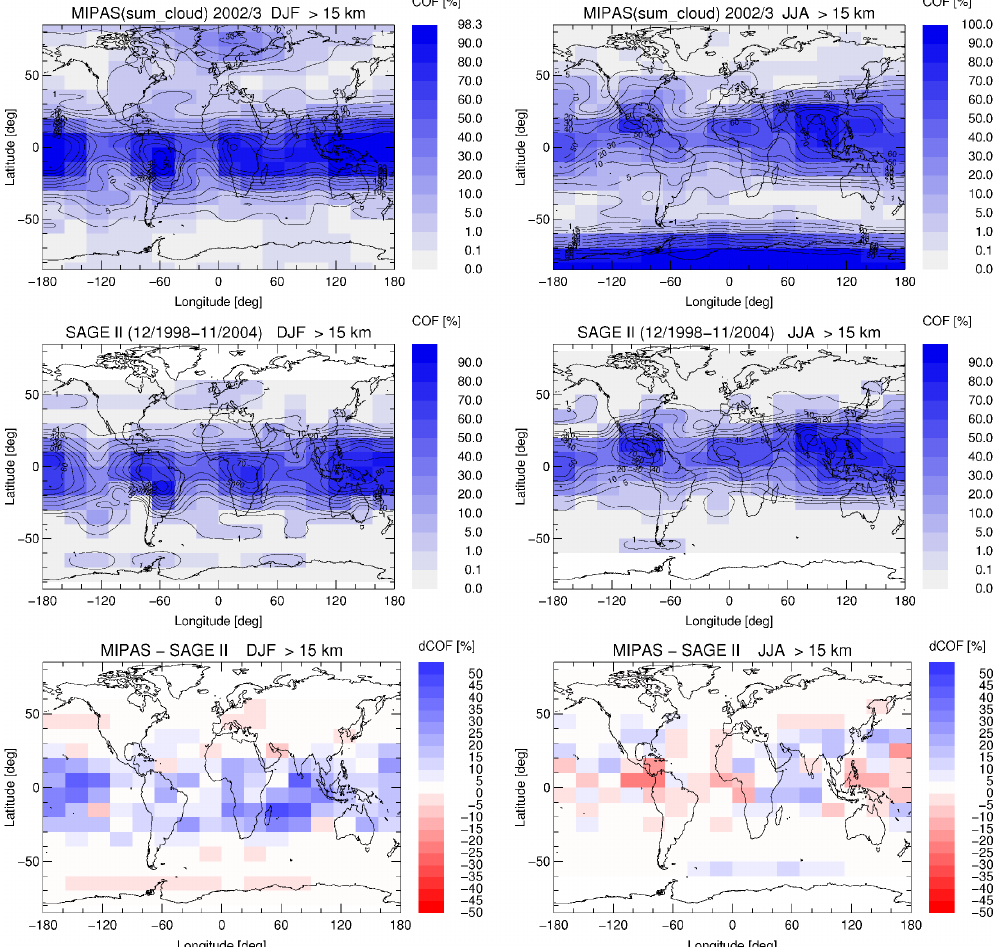
Fig. 14. MIPAS (top) parameter SUM CLOUD for DJF and JJA 2002/2003 and SAGE II (middle) SVC climatology of occurrence frequen- cies and the corresponding differences of MIPAS-SAGE II (bottom panels) for altitudes above 15km. Overlaid contour lines run from 1, 5, 10, 20... to